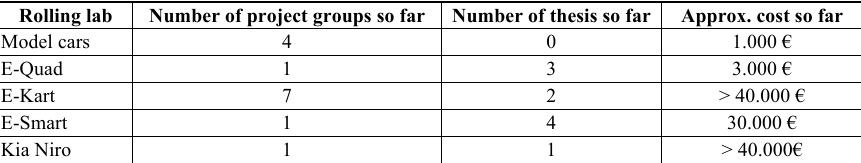
Table 2. PBL approach for the